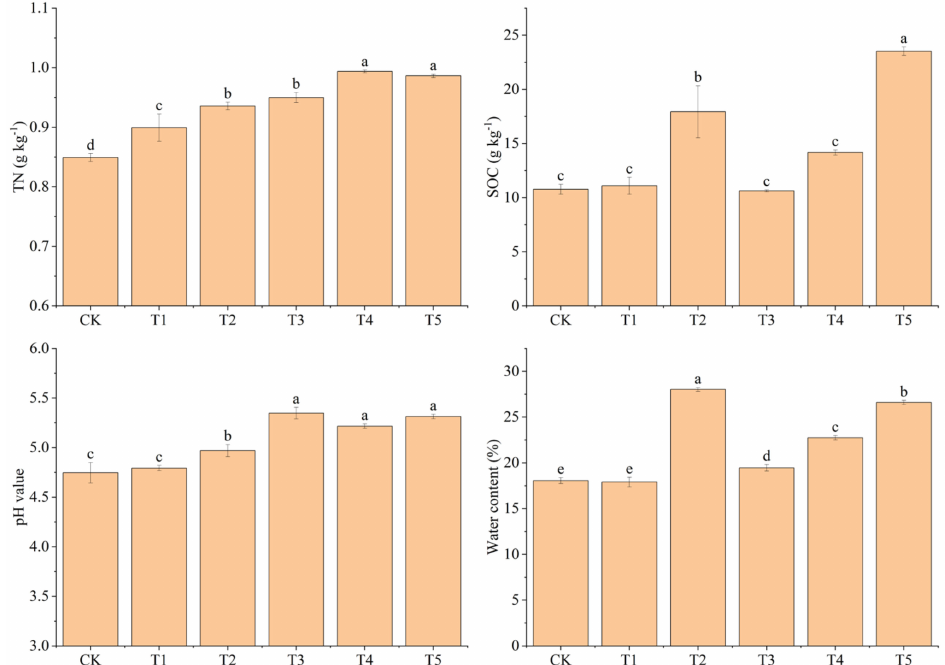
Figure 4. Effects of different treatments on soil organic carbon (SOC), soil total nitrogen (TN), soil pH values, and soil water content. CK: no biochar and no N addition; T1: 0.64% biochar + 0% NH 4 NO 3 ; T2: 1.28% biochar + 0% NH 4 NO 3 ; T3: 0% biochar + 1.28% NH 4 NO 3 ; T4: 0.64% biochar + 1.28% NH 4 NO 3 ; T5: 1.28% biochar + 1.28% NH 4 NO 3 . Bars (standard deviation) followed by